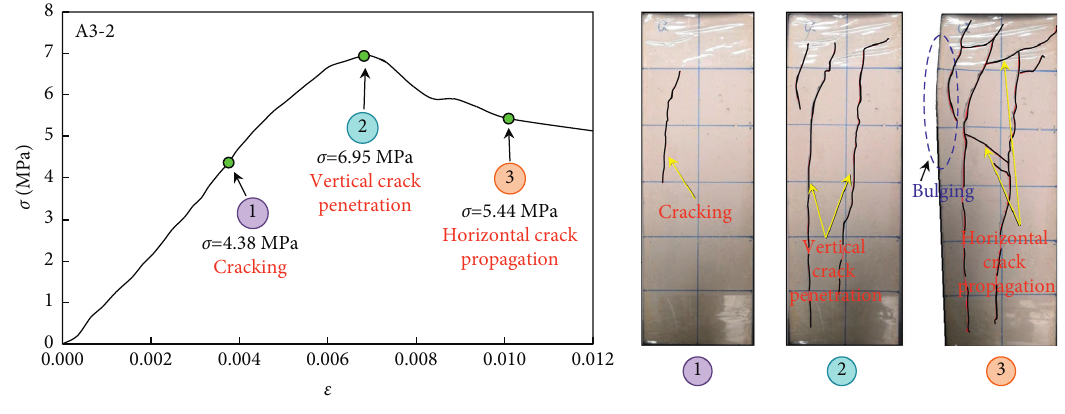
Figure 6: Failure process of specimen A3-2.